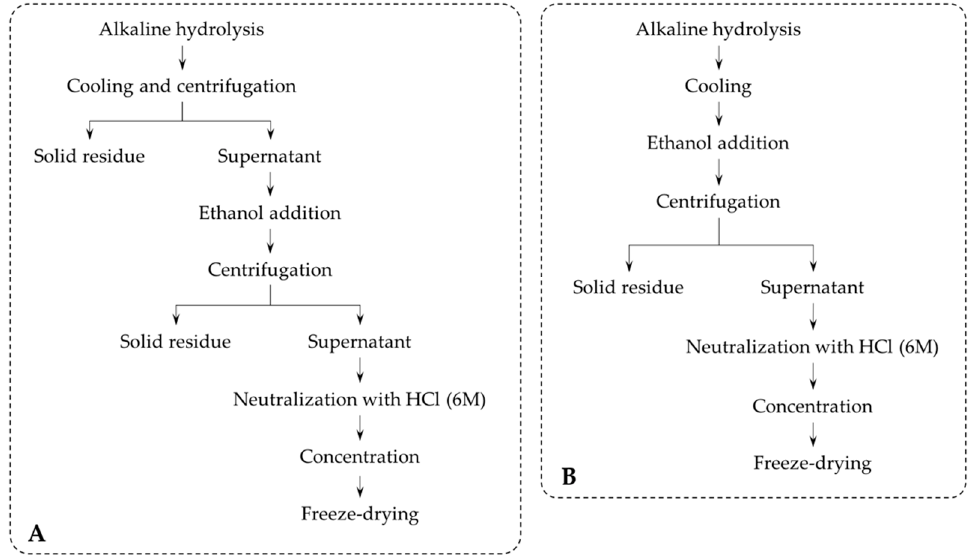
Figure 1. Proceeding to the alkaline hydrolysis reaction. ( A ) classic procedure; ( B ) simplified methodology.